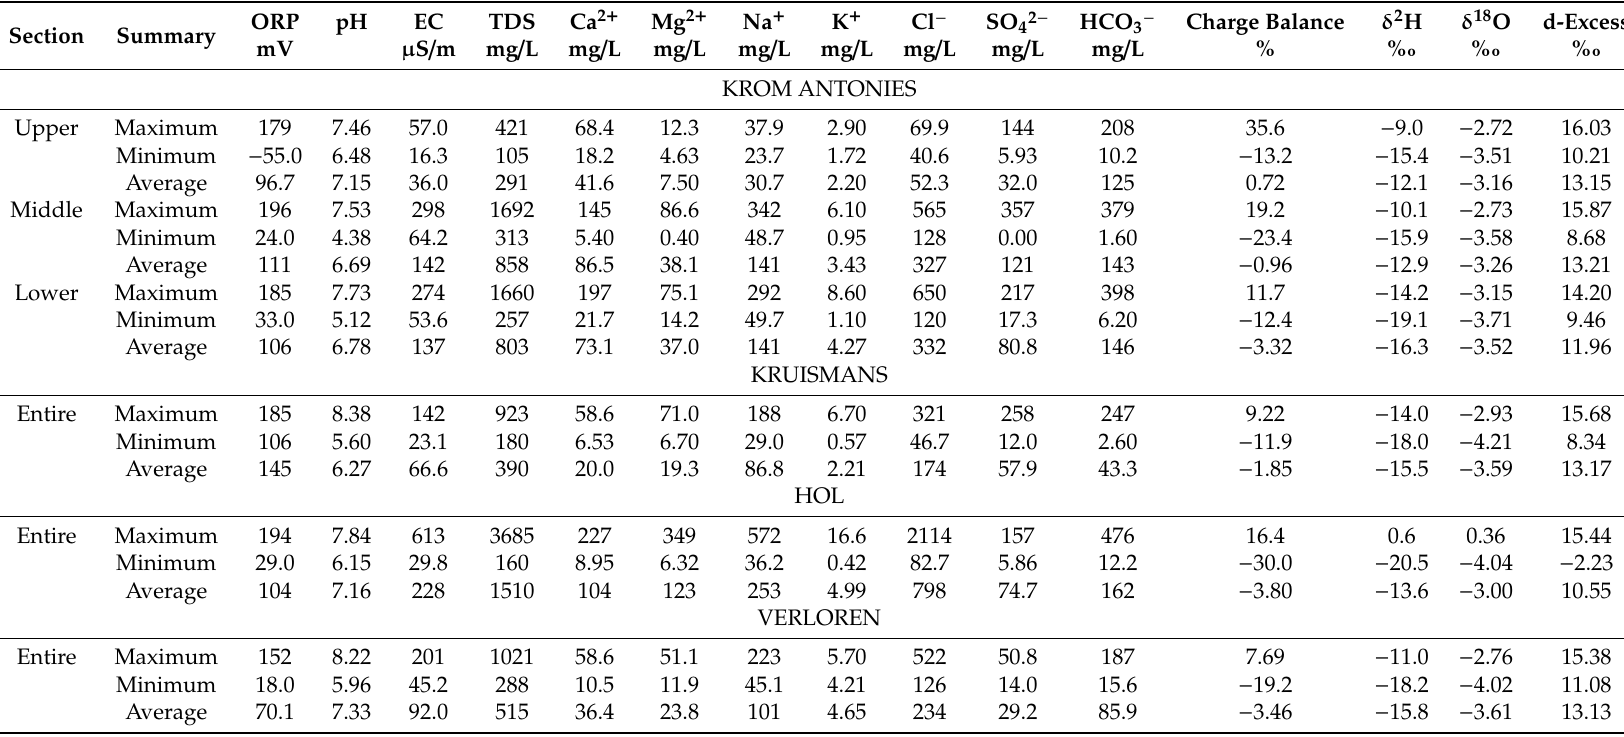
Table 2. Summary of groundwater samples collected along the upper, middle and lower Krom Antonies as well as the Kruismans and Hol tributaries and Verloren River. Full data available in Tables